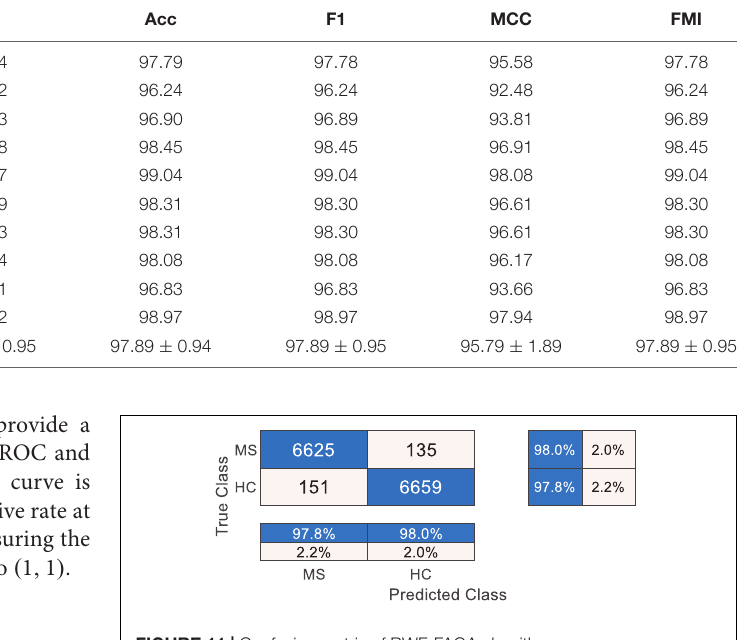
FIGURE 11 | Confusion matrix of BWF-FAGA